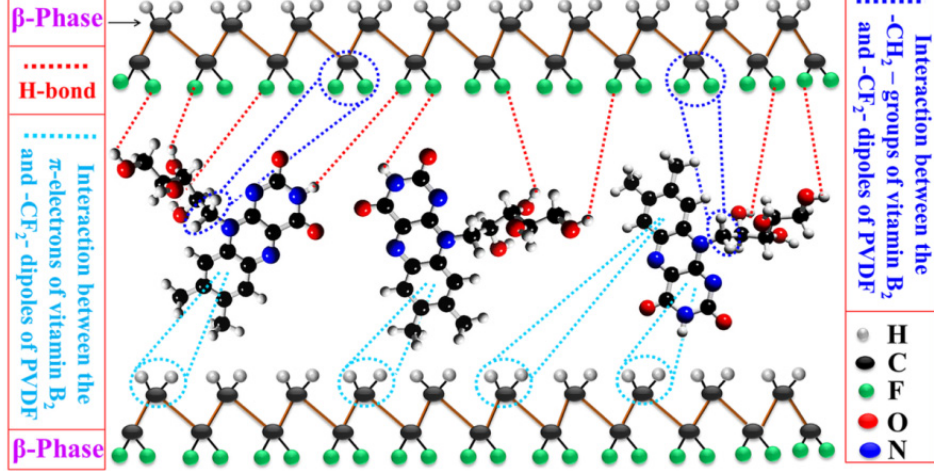
Figure 9. Schematic of various interactions between the PVDF dipole and vitamin B 2 (VB 2 ) [76]. Reproduced with the permission from reference [76].